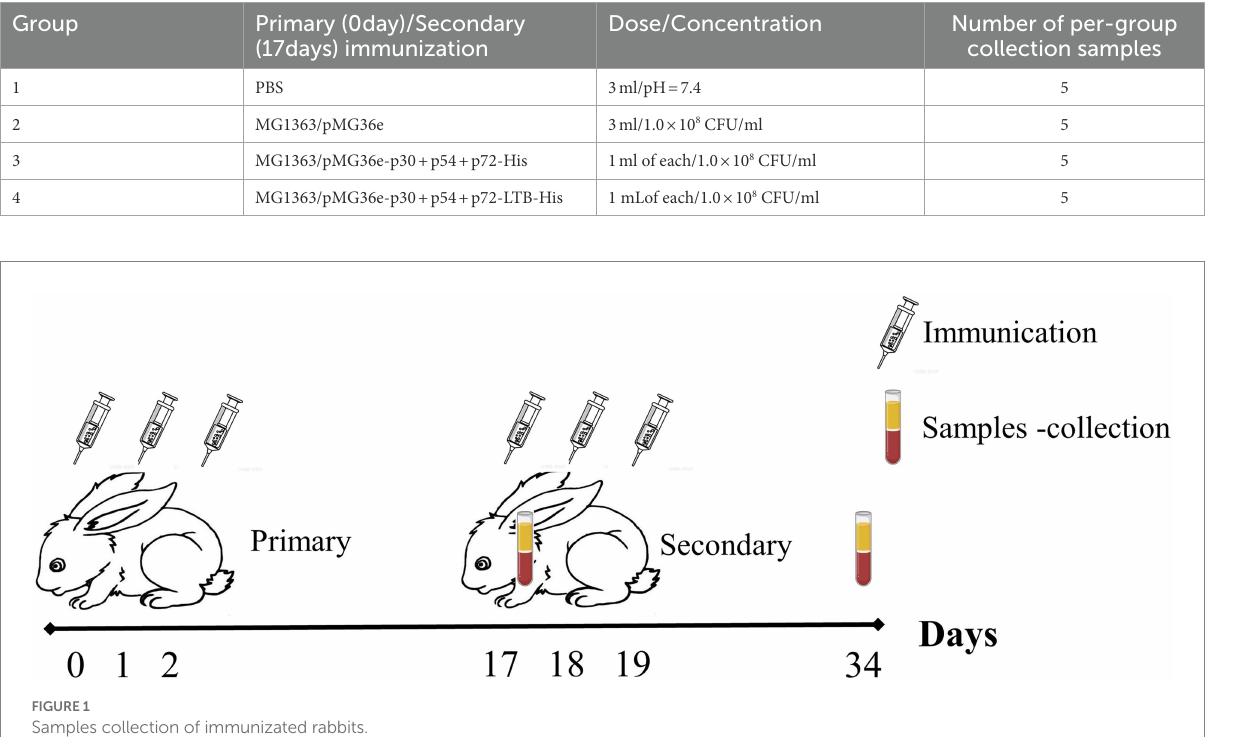
FIGURE 1 Samples collection of immunizated